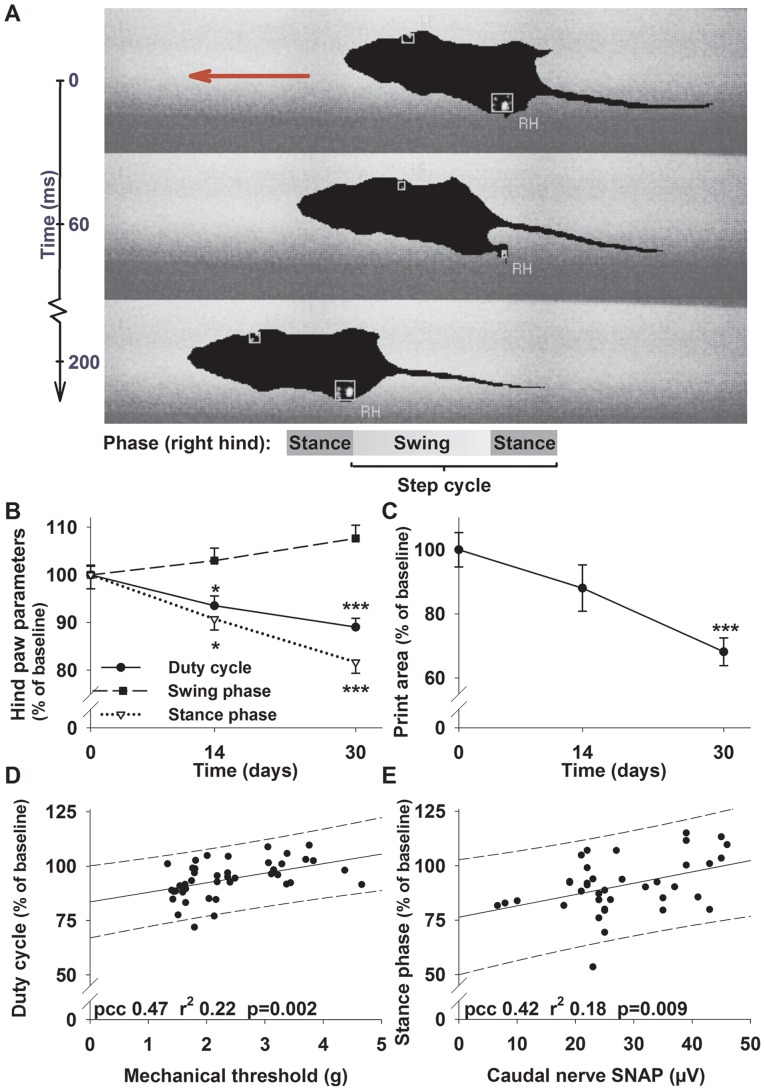
Paclitaxel induced polyneuropathy can be detected with the Catwalk method.(A) A typical Catwalk run; the animal crosses from right to left. Paws are automatically detected and labeled by the program, in this example right hind paw (RH) and the left forepaw. Examples of gait parameters for the right hind paw are displayed at the bottom of the graph in respect to the step cycle. (B) Animals treated with paclitaxel develop distinct gait alterations compared to vehicle controls. The swing phase (squares, long dashed line) increases, while the stance phase (open triangles, dotted line) and the duty cycle (circles, solid line) decreases. Duty cycle expresses the stance phase as a percentage of the entire step cycle (stand + swing). (C) The print area of the hind paws is also significantly reduced in neuropathic animals. (D) The duty cycle of the hind paws shows a small correlation with the mechanical withdrawal threshold of the animals. Similar results are obtained for the correlation of the (E) hind paw stance phase duration with the caudal nerve SNAP. Solid lines in (D-E) signify linear regression lines, while medium dashed lines depict the 95% prediction interval. * p<0.05; *** p<0.001; both compared to the control group at the same time point (One-way ANOVA).